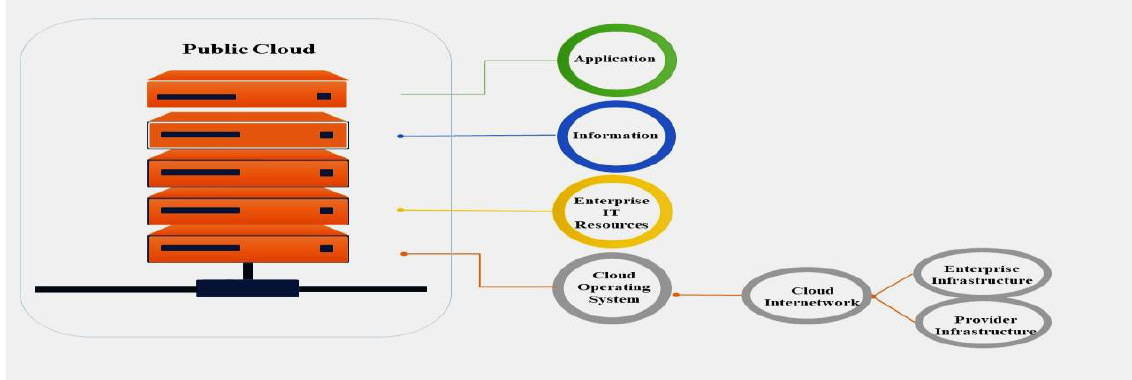
Figure 2. Public cloud computing.